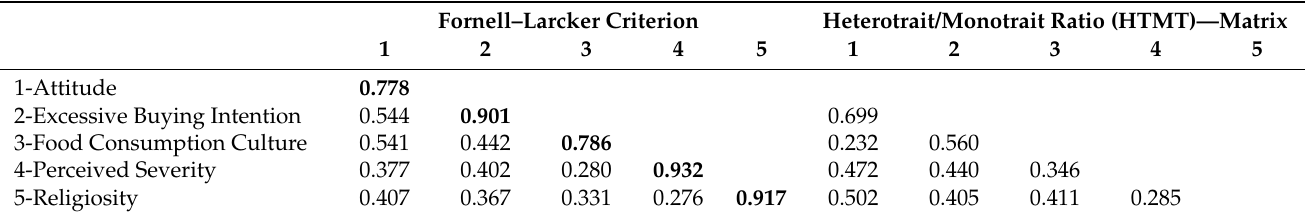
Table 3. Fornell–Larcker criterion and Heterotrait/monotrait ratio